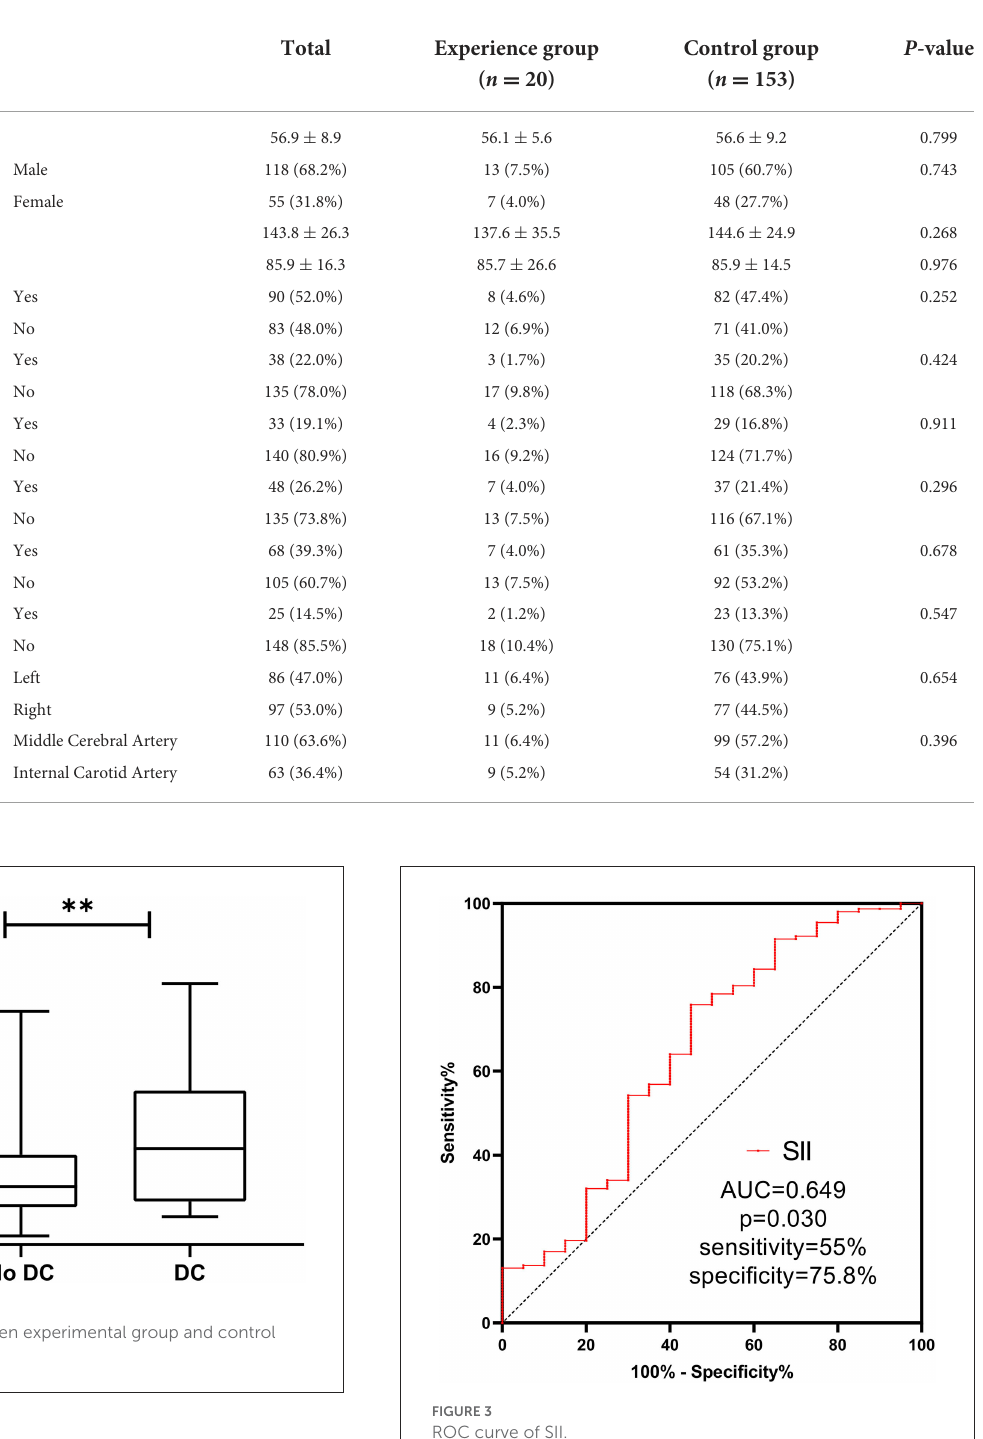
FIGURE3 ROC curve of SII.